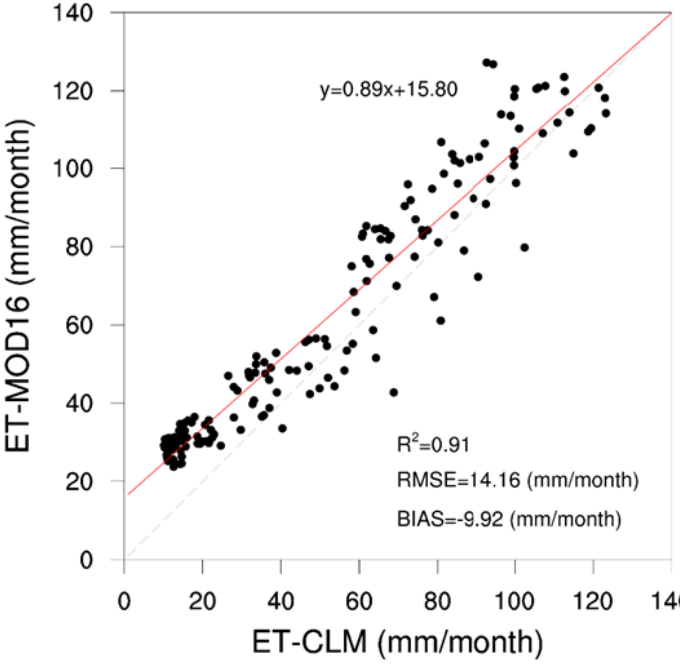
Figure 6. Scatter plot of ET-MOD16 and ET-CLM.